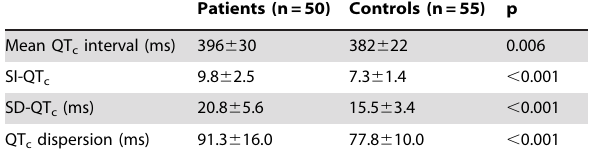
Table 2. Magnetocardiography-derived parameters in patients with patients with thalassemia major and control